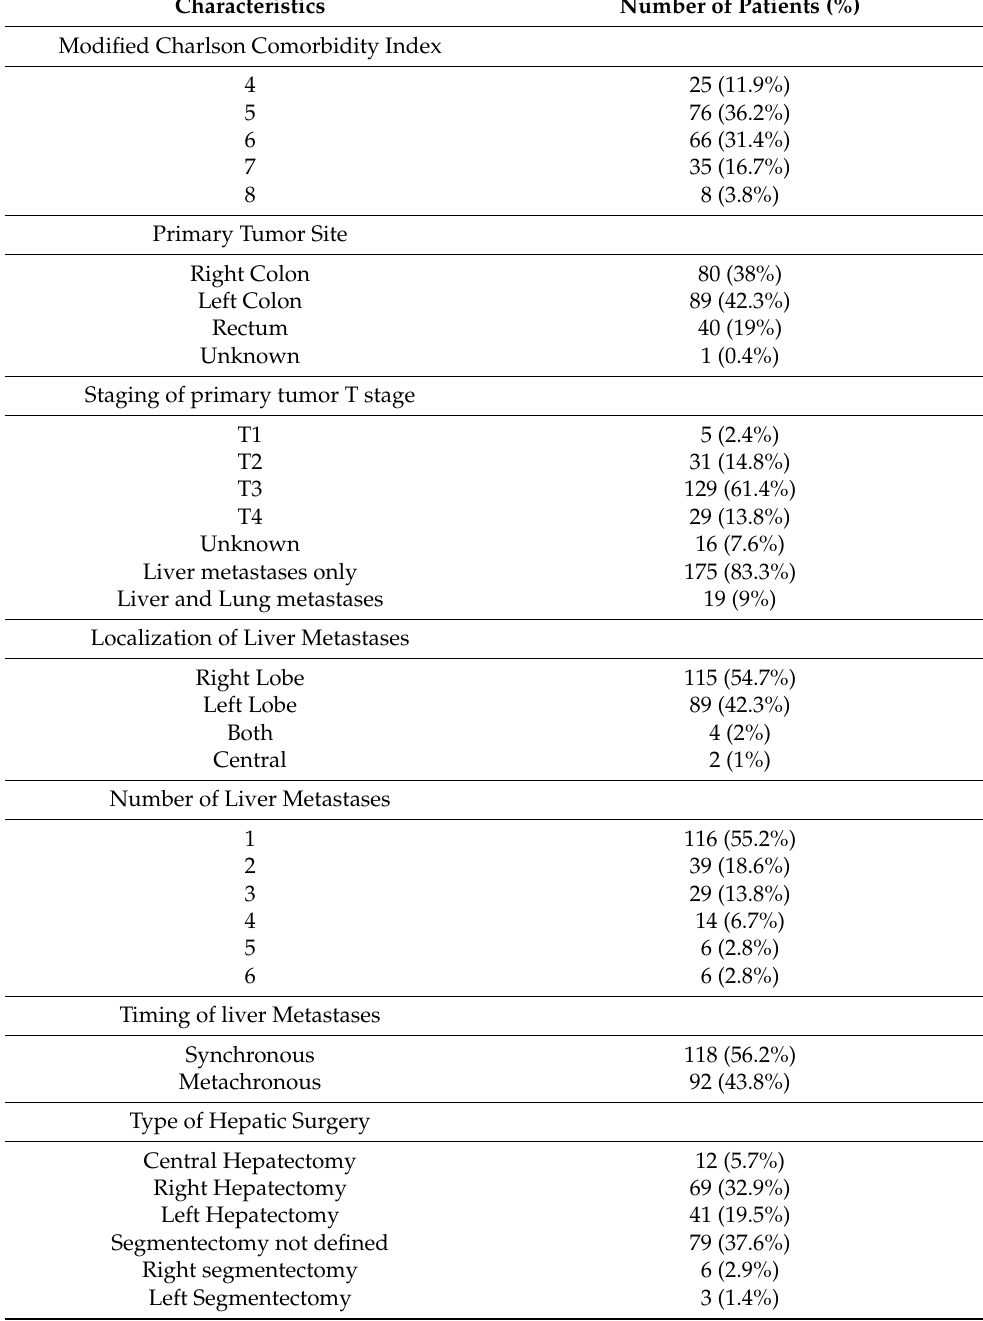
Table 1. Clinical and Surgical characteristics of the 210 patients of the